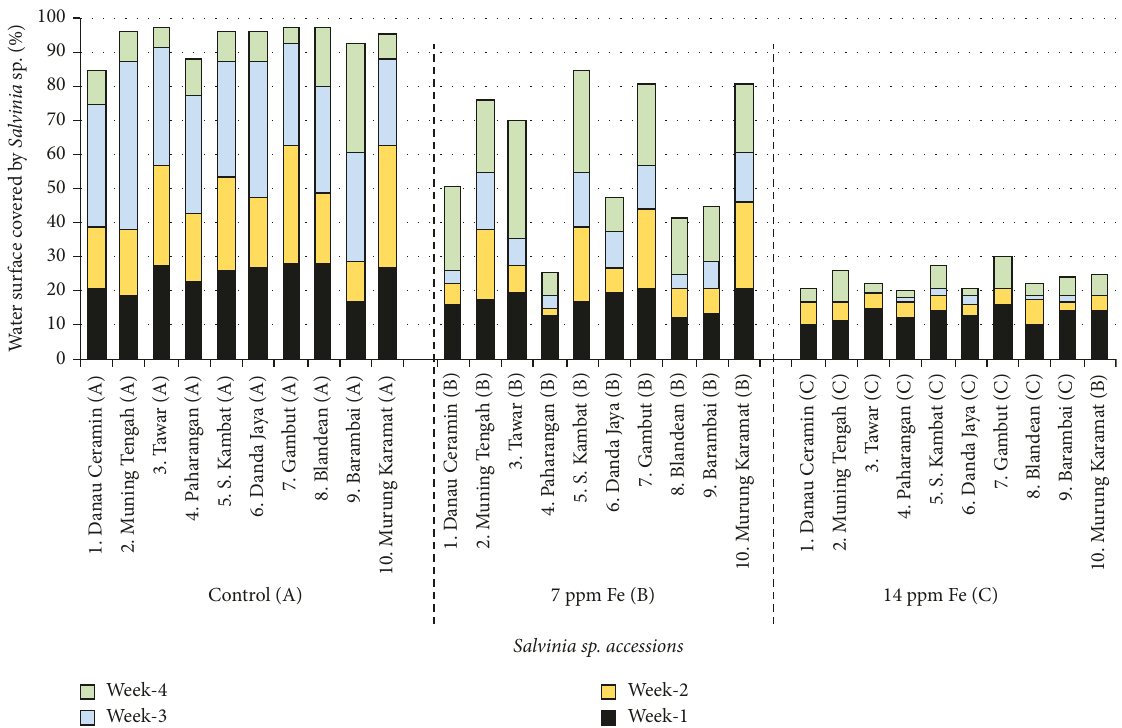
Figure 2: Water surface covered by Salvinia sp. during 4 weeks of maintenance in Hoagland nutrient solution medium enriched with various levels of Fe.